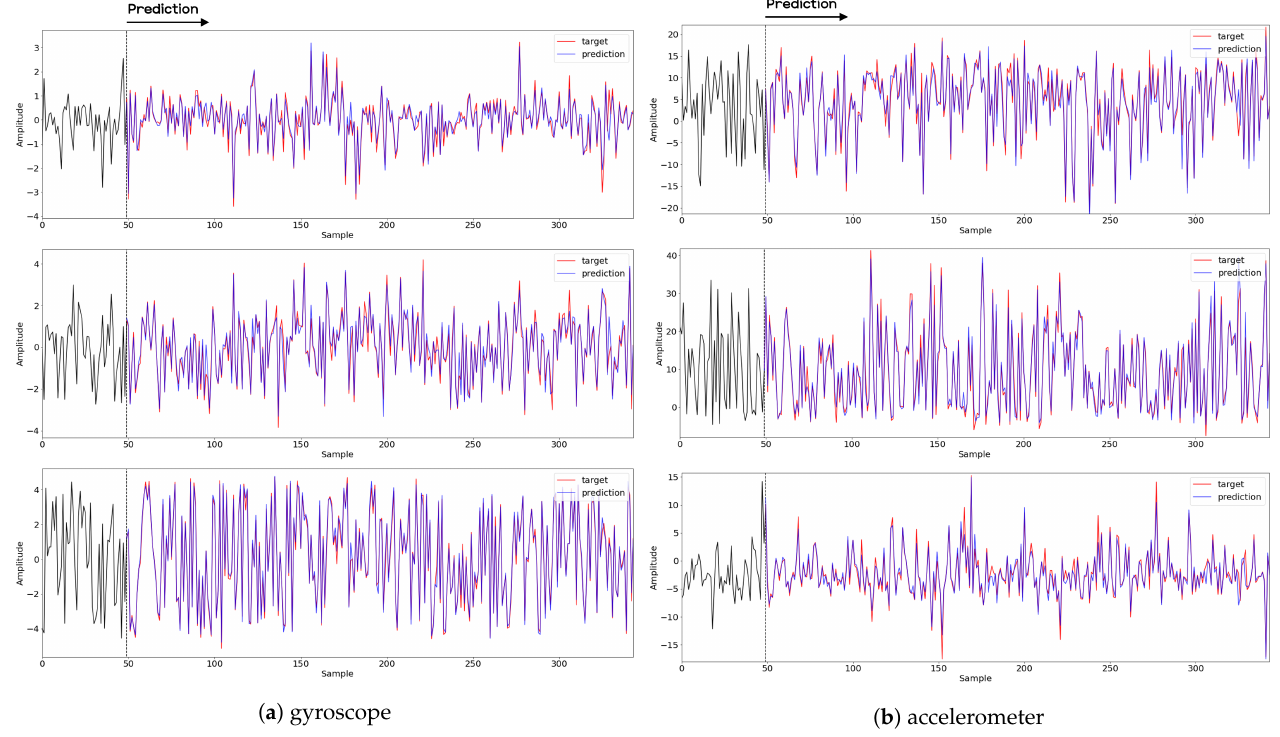
Figure 23. Samples of recovery results from the decoder model for running motion. The top, middle, and bottom rows represent the x-, y-, and z-axis, respectively. The blue and red lines indicate the predicted signal from the FNO model and target signal, respectively, and the black line represents the signal corresponding to the input entered into the FNO